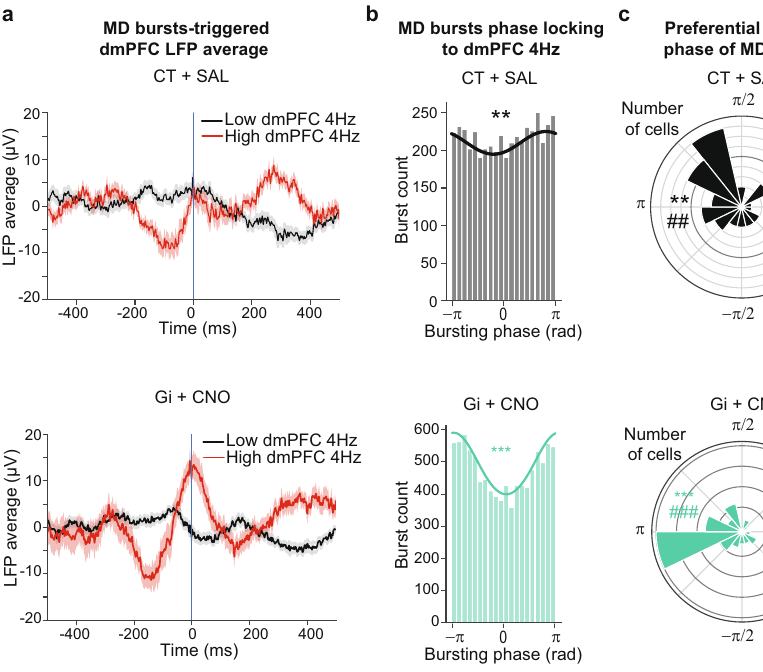
Fig. 7 | Phase-locking of MD bursting to dmPFC 4Hz LFP oscillations during EXT1 is increased by chemogenetic inhibition of FN-MD. a Average of dmPFC LFP (average± SEM), around MD bursts occurringduring episodesof either high dmPFC 4Hz (red) or low dmPFC 4Hz) red, for CT+SAL (top) and Gi+CNO (bottom). b Phase histograms of MD bursting during episodes of high 4Hz, for CT+SAL mice (top) and Gi+CNO mice(bottom). Thesolid line representsaVon Mises fi t associated to the circular distribution. Rayleigh test ** p <0.01, *** p <0.001. c Distributions of preferential bursting phases of MD neurons during episodes of high 4Hz, for CT+SAL mice (top) and Gi+CNO mice (bot- tom). Rayleigh test ** p <0.01, *** p <0.001. Circular V test, testing for a unimodal circular distribution centered on pi (which corresponds to positive peaks in dmPFC 4Hz oscillations) ## p <0.01, ### p <0.001. d The average amplitude